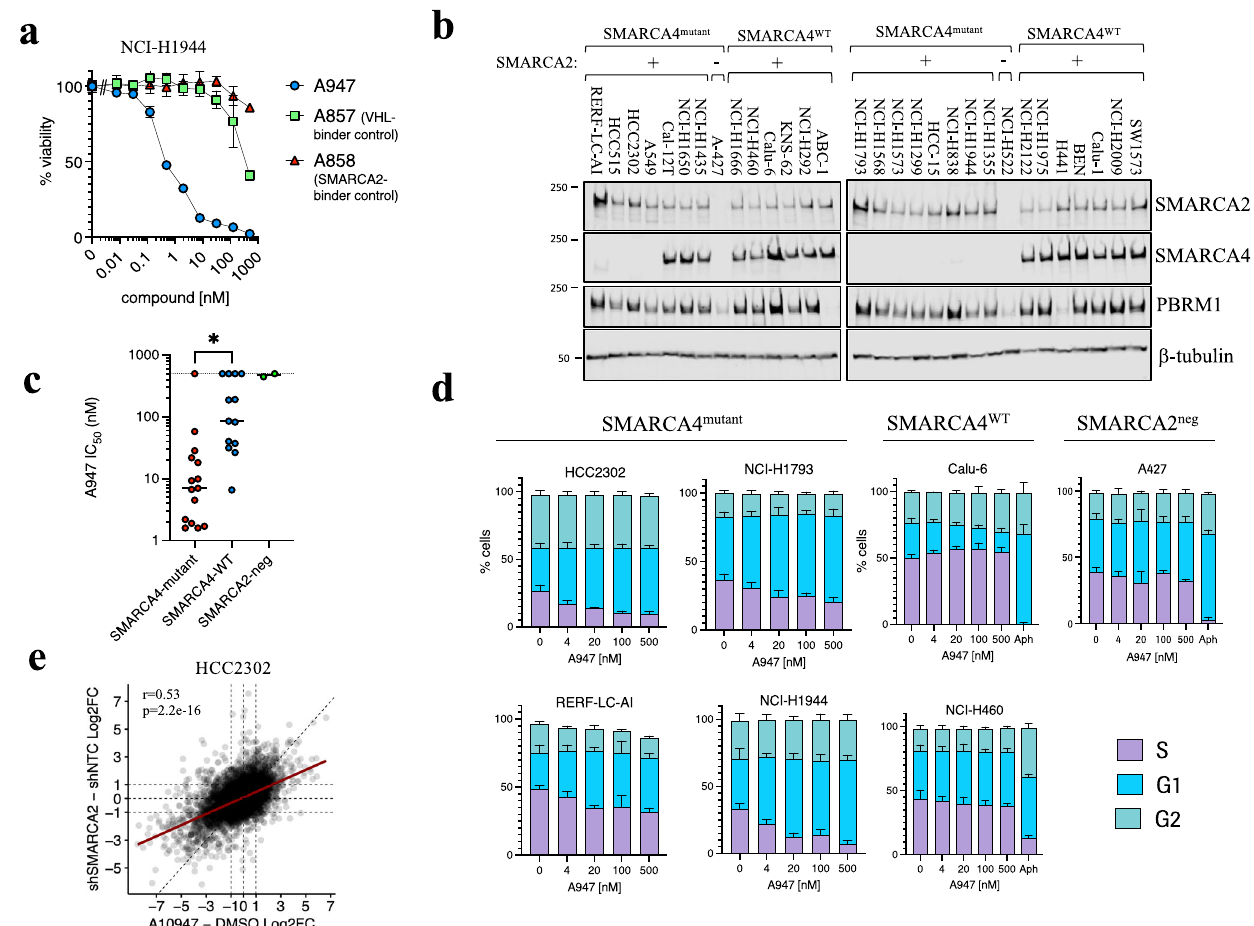
Fig. 3 | A947-mediated inhibition of cell proliferation in SMARCA4-mutant NSCLCcelllines.a ViabilityofNCI-H1944following7daysoftreatmentwithadose response of A947 or binding-defective epimers. Error bars represent mean±SD from n =3 biologic replicates. b Immunoblots of SMARCA2, SMARCA4 and PBRM1 levelsacrossapanelofNSCLCcelllinesde fi nedby SMARCA4 genemutationstatus. β -tubulin serves as a loading control. Data are representative of 2 independent experiments. c Effect of A947 treatment on the growth of 30 lung cancer cell lines de fi ned by SMARCA4 or SMARCA2 status, represented as the concentration of A947 required to inhibit growth by 50% (IC 50 ) following 7 days of treatment. Indi- vidual cellline IC